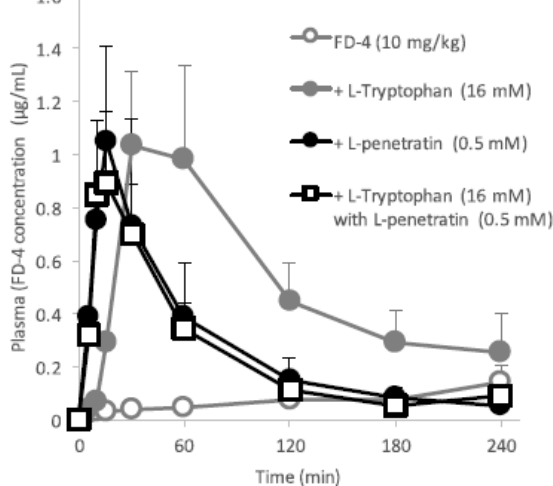
Figure 12. Time profiles of plasma concentrations of FD-4 after its in situ administration with or without L -tryptophan (16 mM) and/or L -penetratin (0.5 mM) into rat ileal loop. Each data point represents the mean ± SEM of N = 3–4.